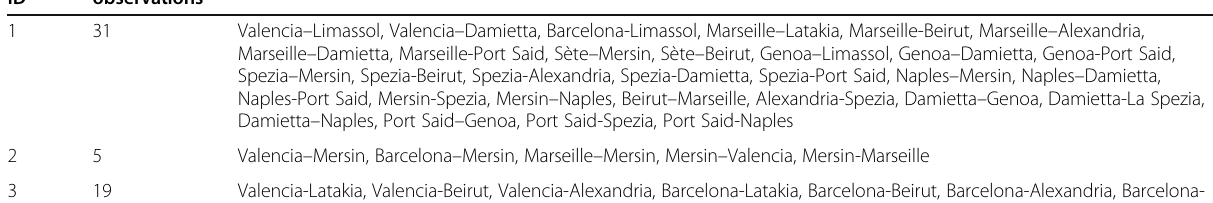
Table 9 Clustering Results - Existing Network Cluster N. of ID